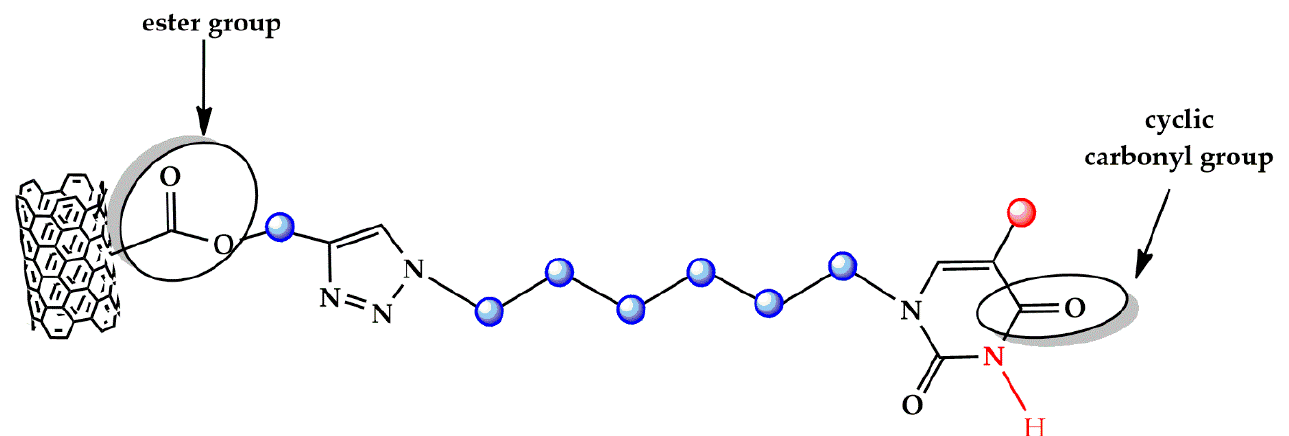
Figure 4. Chemical structure of MWCNT-t with the characteristic functional groups highlighted.